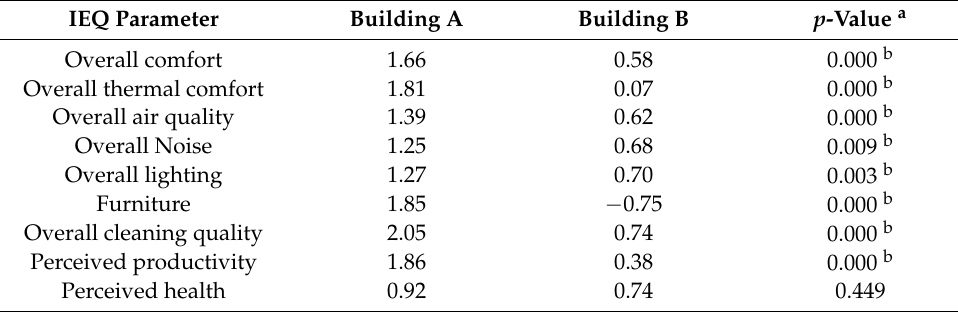
Table 5. Comparison of IEQ parameters between buildings A and